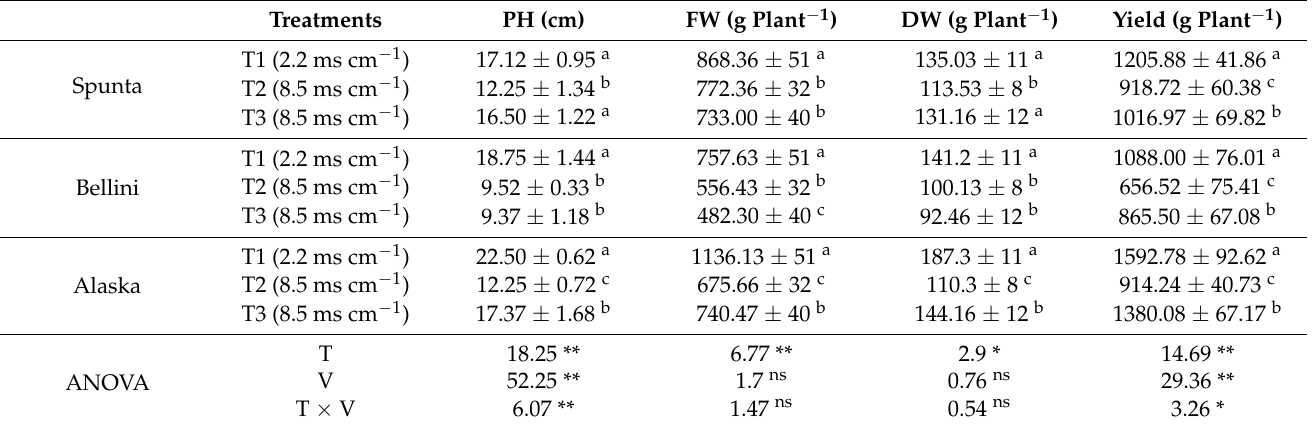
Table 1. Changes in plant height (PH), fresh weight (FW), dry weight (DW) and yield of potato varieties (Spunta, Bellini and Alaska), for each irrigation treatment. Treatments